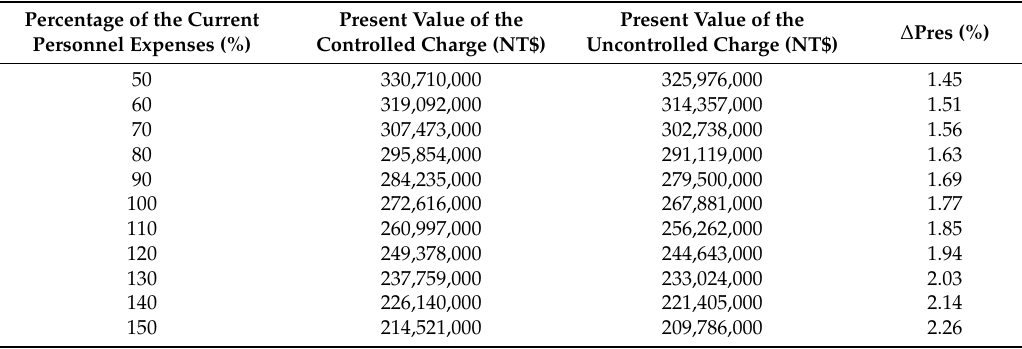
Table 10. Detailed sensitivity results of the personnel expense